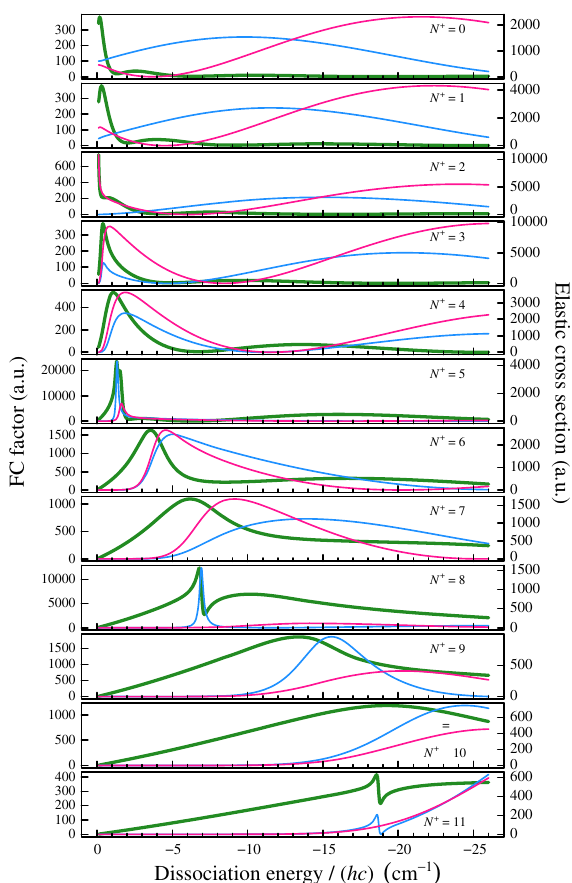
FIG. 7. Bound-continuum Franck-Condon (FC) factors for ¯ H transitions from the ð v ¼ 12 Þ state to the D þ þ D dissociation channels with angular-momentum quantum numbers N þ ¼ 0 – 9 , respectively. The solid blue and red lines correspond to the X þ and A þ channels, respectively. The total elastic cross section for the individual partial waves are given by the solid green lines. Note the different vertical